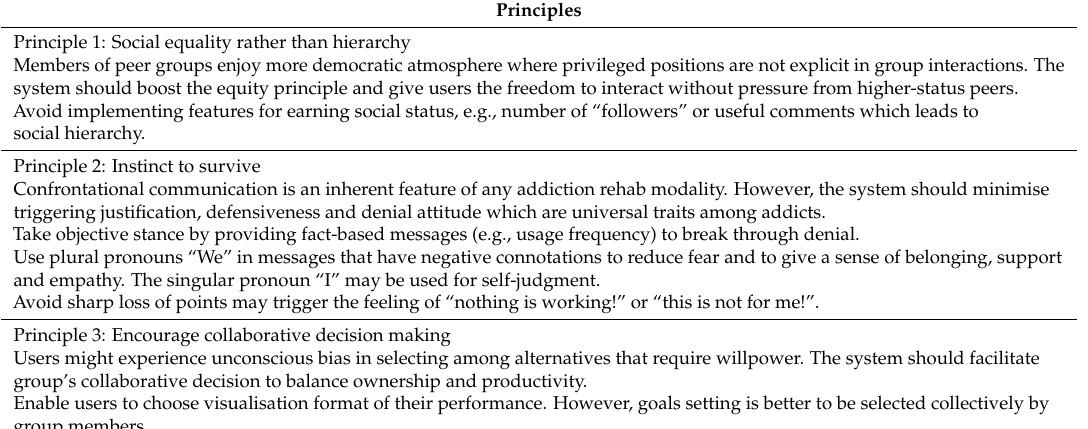
Table 8. Heuristic principles for inspecting online peer groups design to combat addictive behaviours.